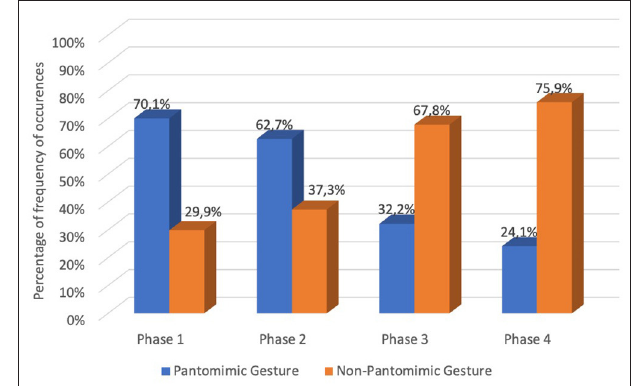
GRAPH 1 | Percentage of frequency of occurrences of pantomime gestures and sign, classifiers, and other gestures along the four phases of collecting